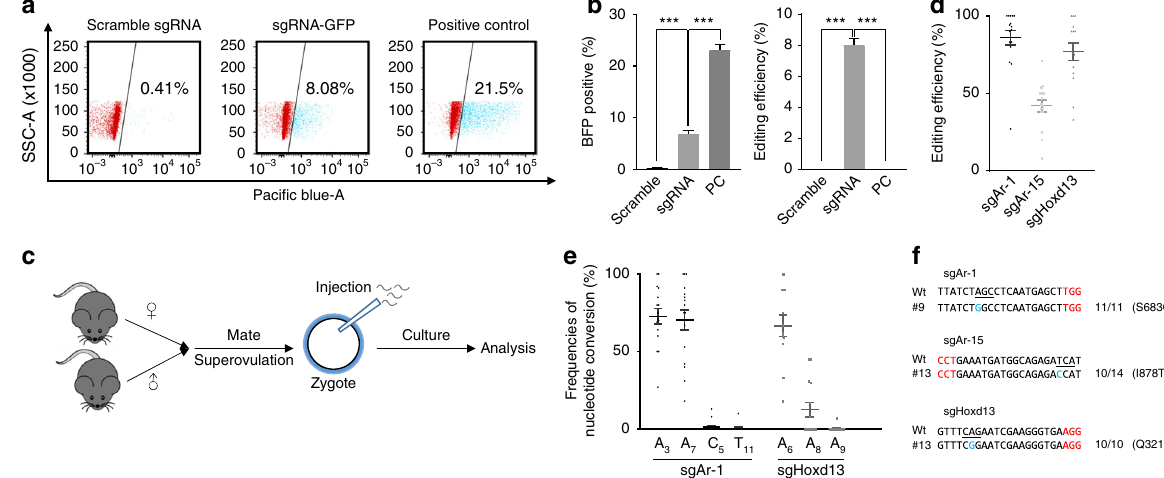
Fig. 1 ABE-mediated ef fi cient A-to-G conversion at Ar and Hoxd13 loci in mouse embryos. a GFP-to-BFP conversion as a reporter for ABE-mediated